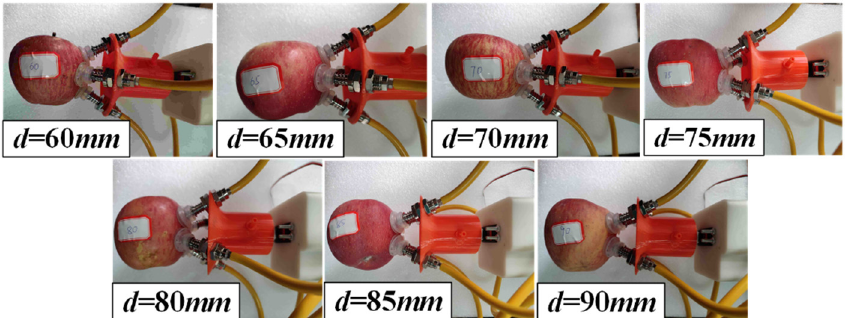
Figure 28. End-effector testing on different apple sizes.